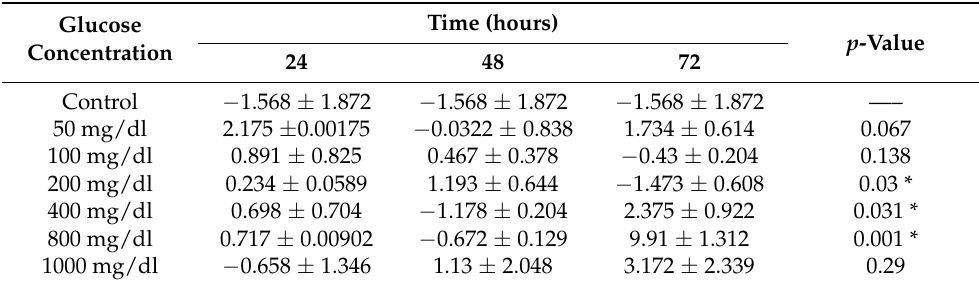
Table 3. ACE2 mRNA